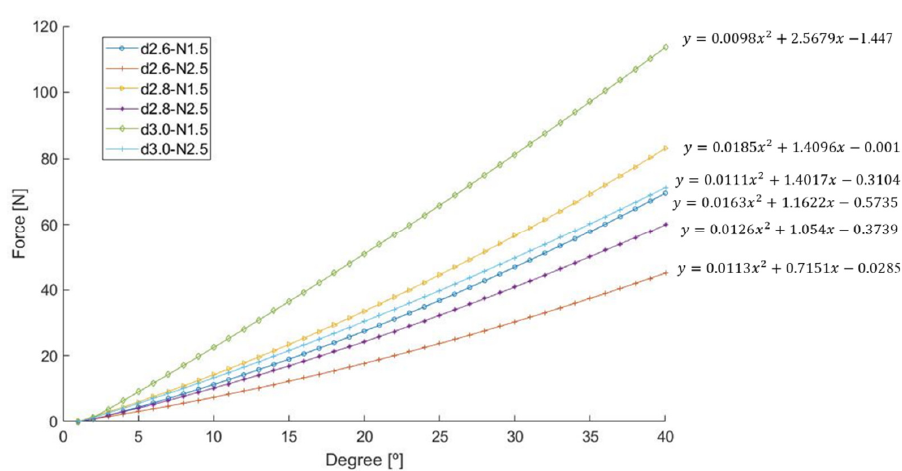
Figure 7. Force vs. degree graph of torsion springs.